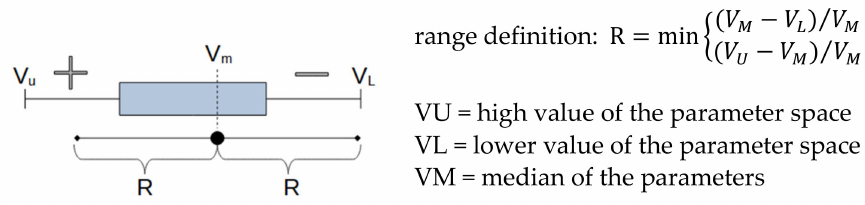
Figure 6. Definition of the parameter range to use the Sensitivity-based Radio Tuning method